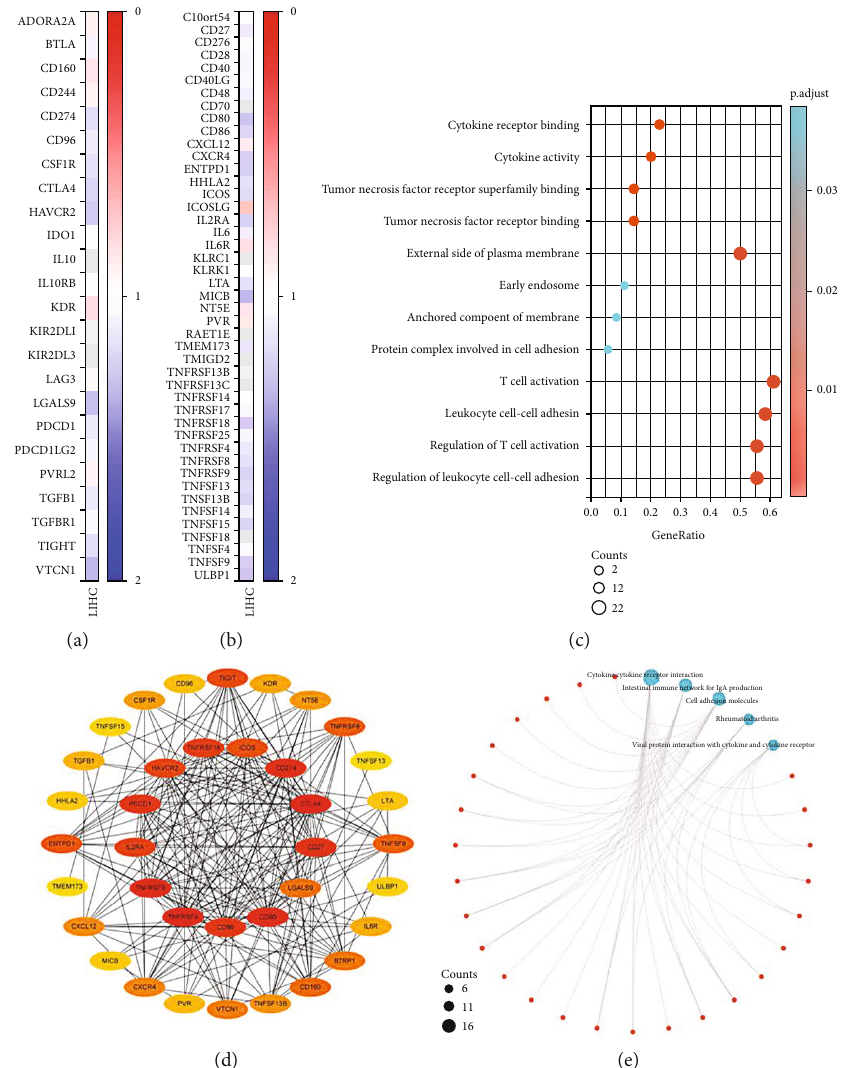
Figure 4: TSPAN9-related immunomodulators and their pathway enrichment in HCC. (a) Heat map of the correlation between HCC immunosuppressants and TSPAN9. (b) The relevance heat map on HCC immunostimulants and TSPAN9. (c) The GEO pathway enrichment analysis of immunomodulators related to TSPAN9 in HCC. (d) Protein-protein network of TSPAN9-associated immunomodulatory closely related genes in HCC. (e) The KEGG pathway enrichment analysis of immunomodulators related to TSPAN9 in